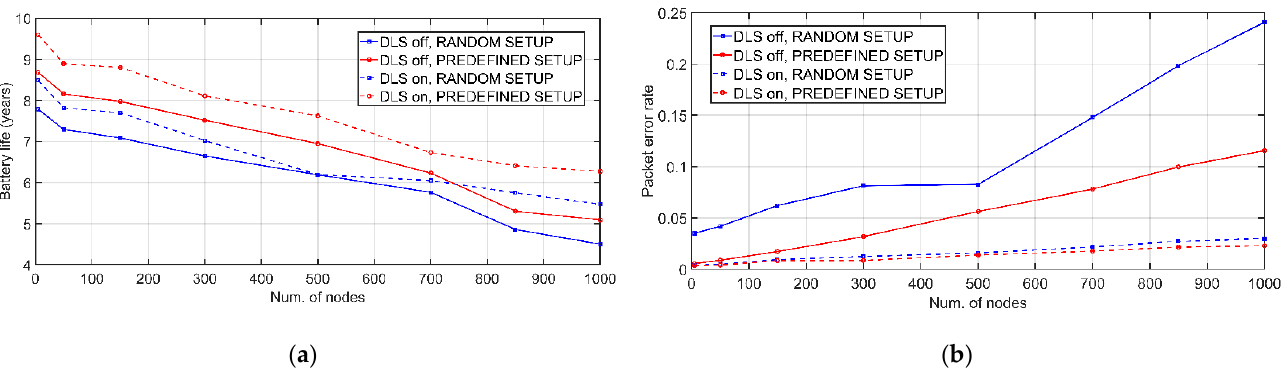
Figure 9. Effects of DLS algorithm on the combined network as a function of network population: ( a ) battery lifetime; ( b ) packet error rate.